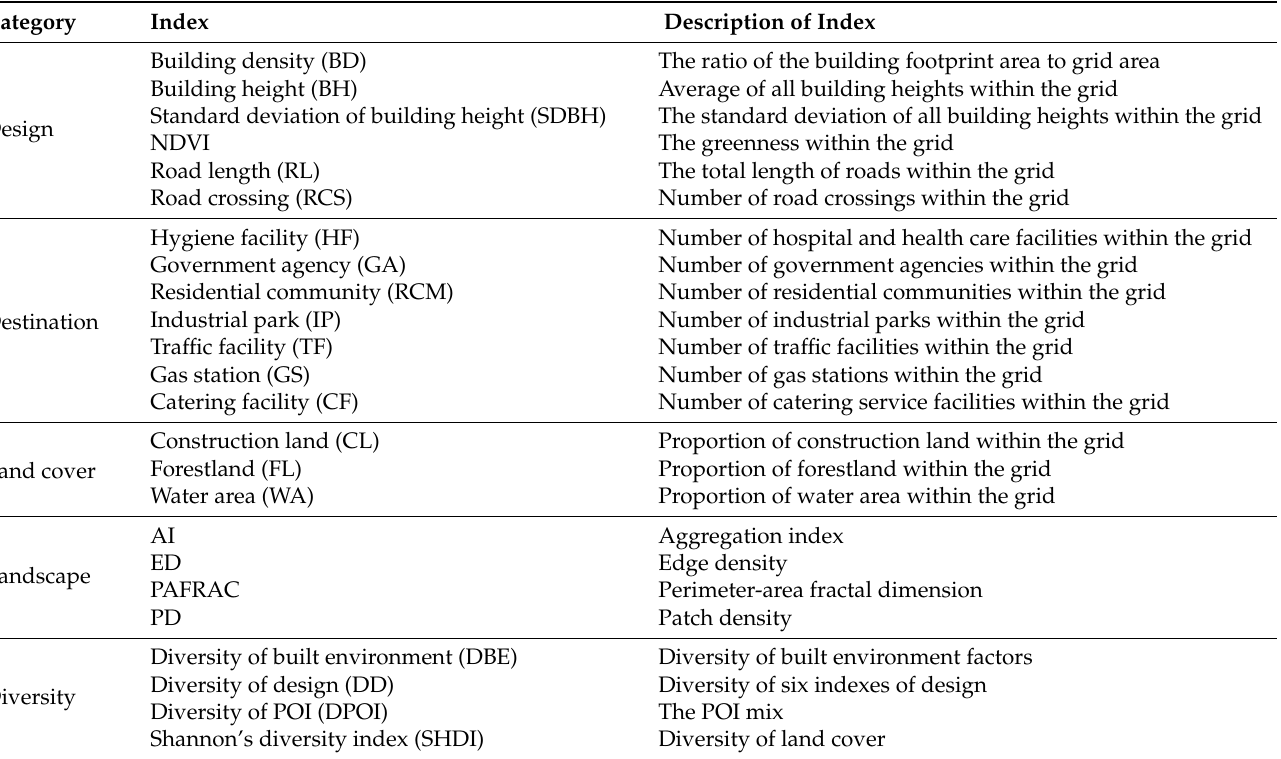
Table 2. Description of 24 indexes of the built